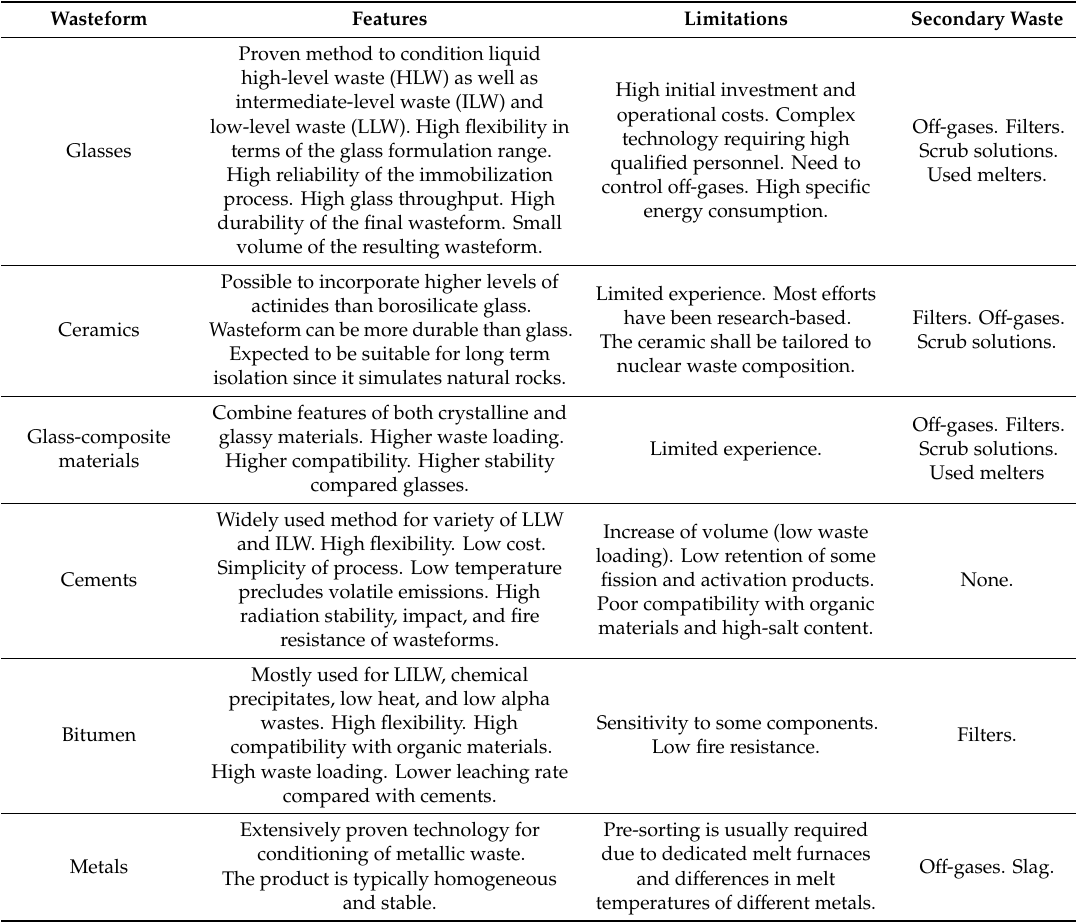
Table 1. Features and limitations of main wasteforms currently